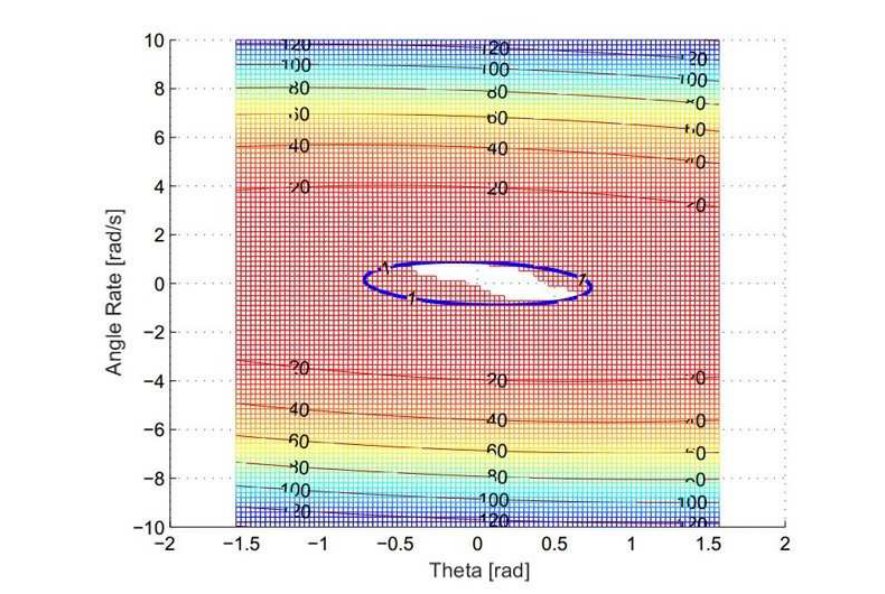
Figure 3. Roll channel